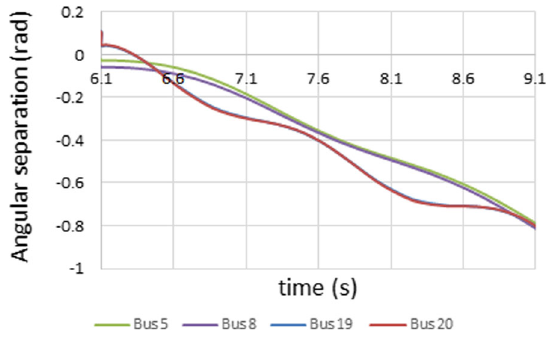
Fig. 21 Bus voltage angular separation post contingency of the weakest bus contributing towards instability. Fur- ther only local phasor values are required for formulating the stability index VSI and further threshold using RVI.